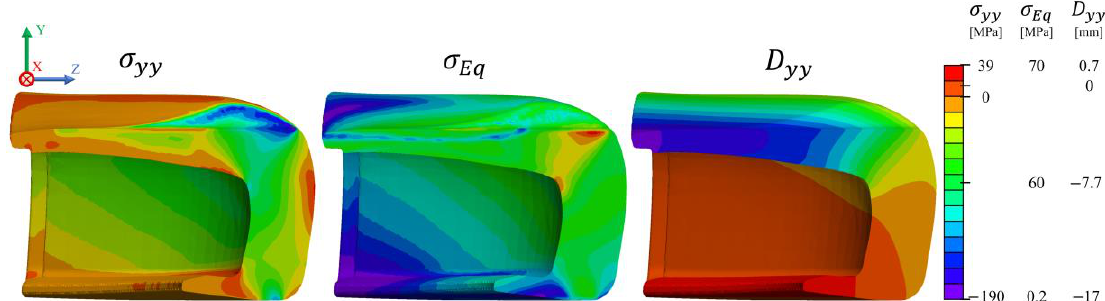
Figure 17. Normal stress ( σ yy ), von Mises Stress ( σ Eq ) and cell y-displacement ( D yy ) distribution in the toe cap for the impact simulation, when Uy striker = 0 m/s.